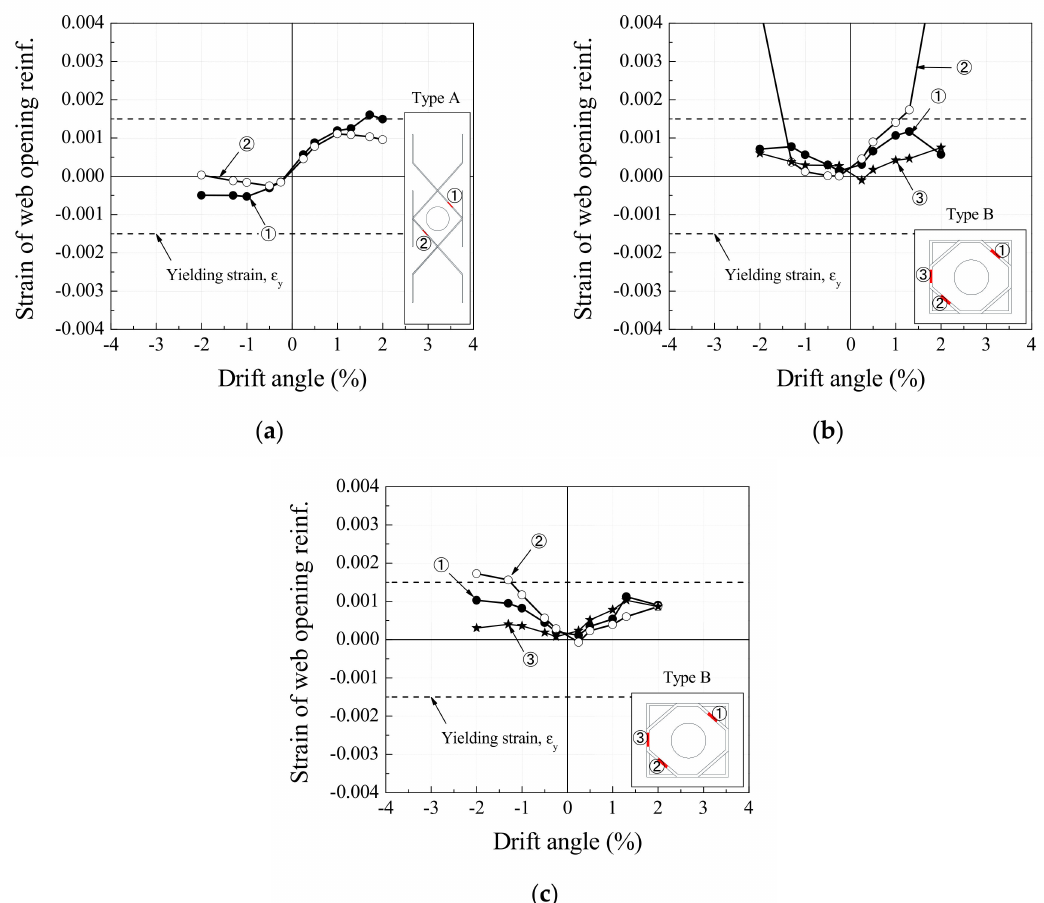
Figure 8. Strain of web opening reinforcement with respect to drift angle: ( a ) No. 3; ( b ) No. 4; ( c ) No.